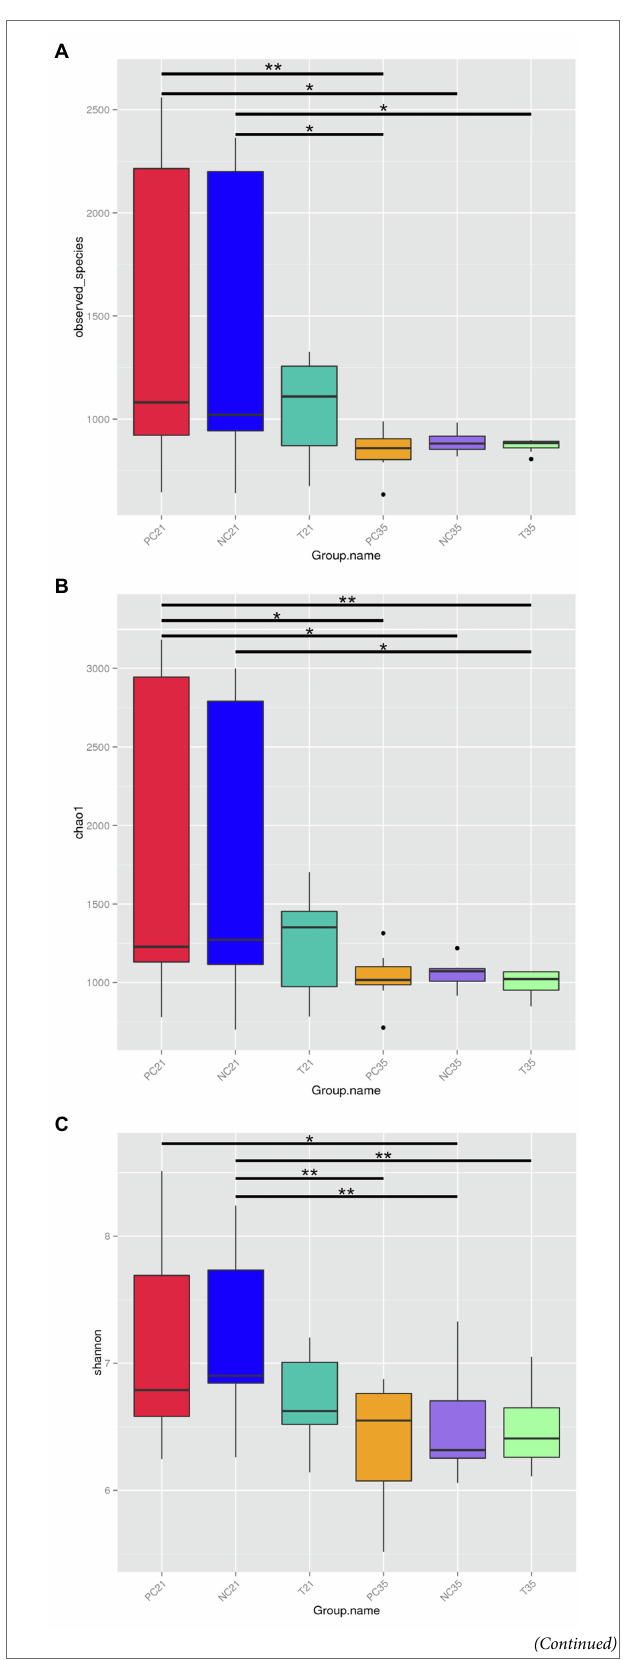
FIGURE 3 | Effects of Z. Tk and ZnO on the intestinal microbiota diversity in weaned piglets in 21 and 35 days based on alpha diversity parameters of observed species (A) , Chao1 index (B) , and the Shannon index (C) . Symbols “*” and “**” indicate significant differences at p < 0.05 and p < 0.01, respectively. Each of the nine samples is selected from each of the three groups of piglets, i.e., the positive control (PC), the negative control (NC), and the test groups, on days 21 and 35,